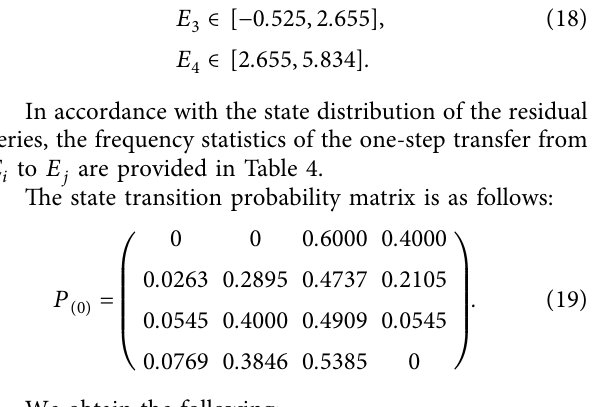
Figure 6: Correlation test of the residual sequence ε SARIMA ( 4 , 1 , 2 )( 1 , 1 , 1 ) 12 model.